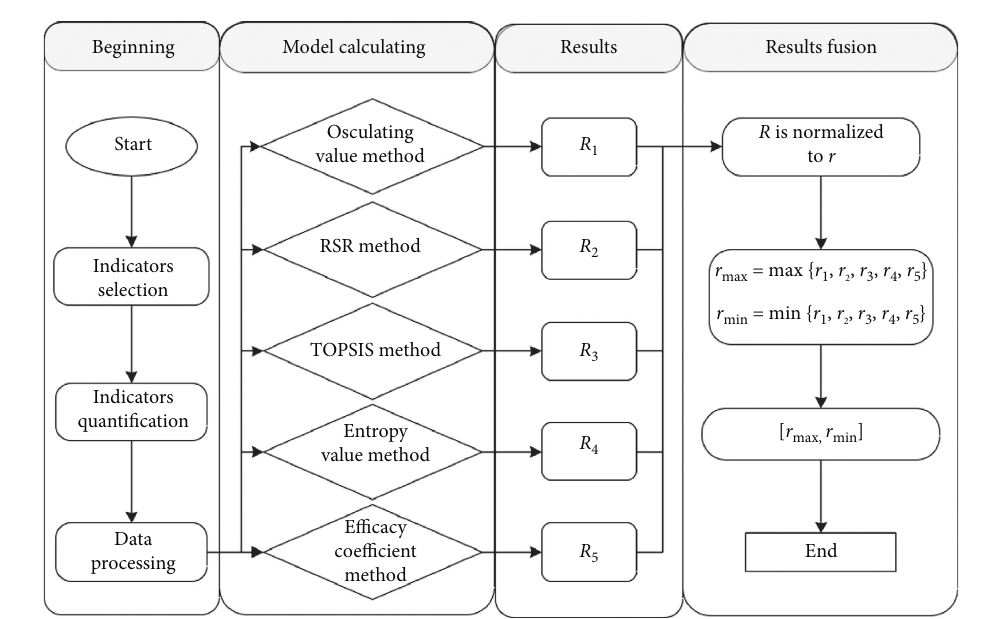
Figure 6: Matching model cluster architecture. Table 3: Matching result of Chinese power companies in Southeast